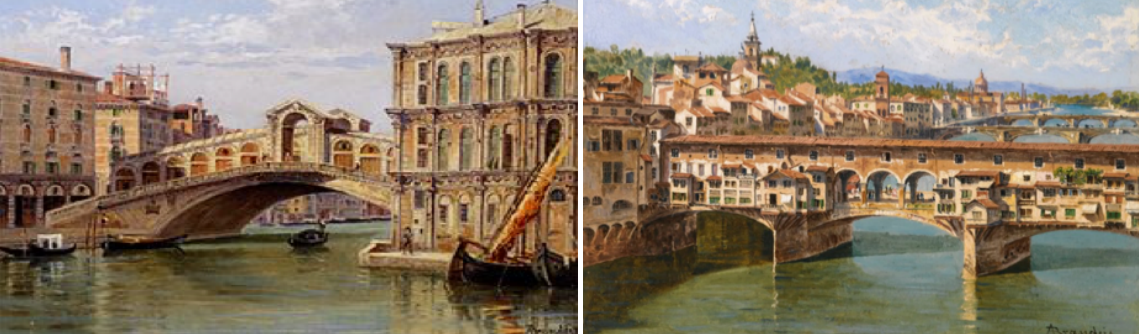
Fig. 6 . Bridges are built on pillars: Ponte di Rialto and Ponte Vecchi0 by Antonietta Bran- deis